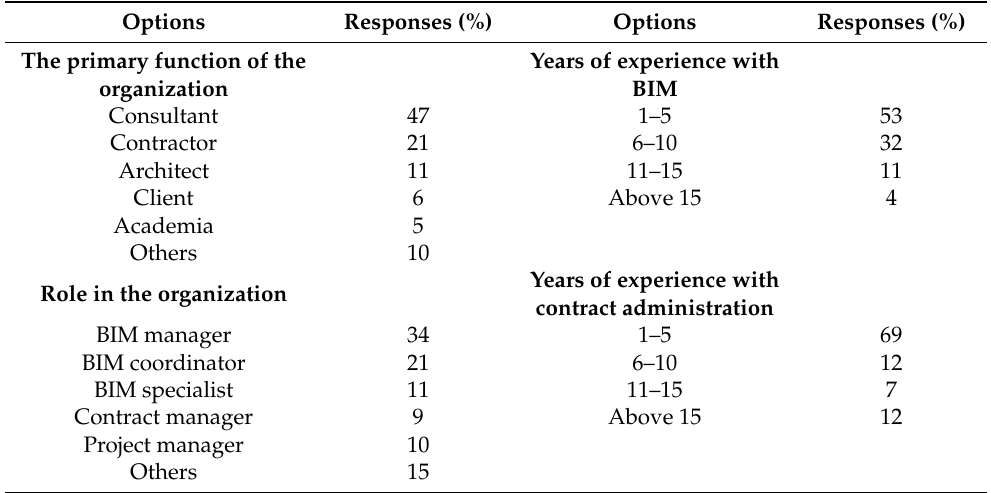
Table 4. Demographic information of respondents.